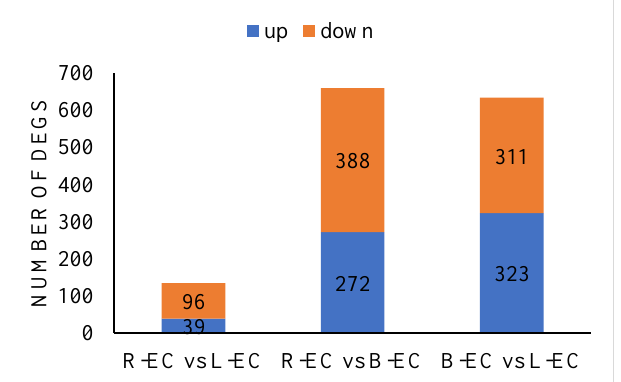
Figure 4. Korean pine transcription factor expression statistics. Table 3. Differences in gene expression of the WRKY, MYB, and AP2/ERF-ERF families of genes among different Korean pine samples.